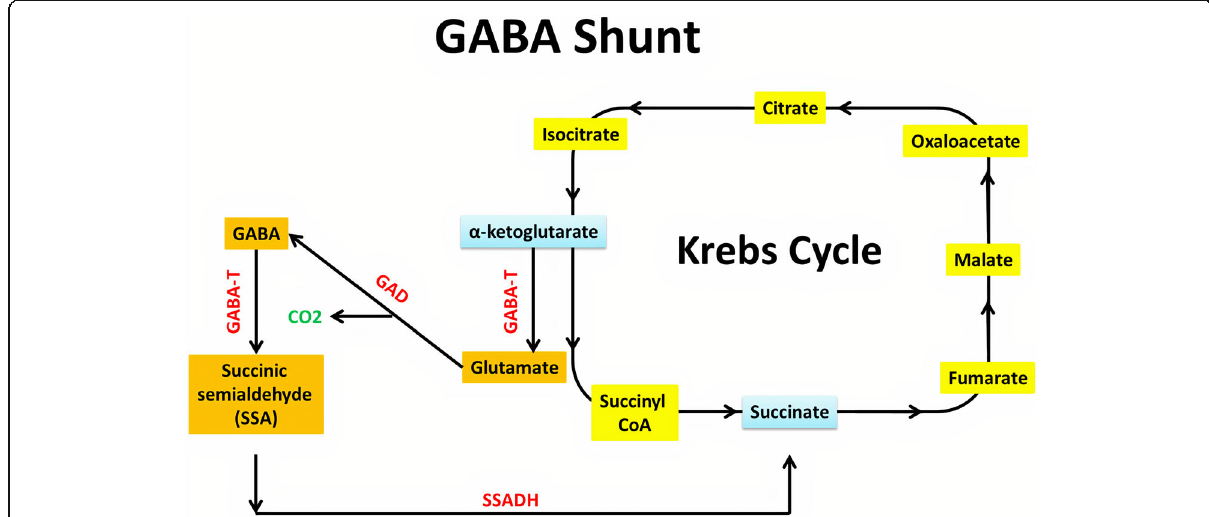
Fig. 2 Schematic illustration of GABA shunt. Transamination of α -ketoglutarate by GABA- α ketoglutarate transaminase (GABA-T) to produce glutamate which is decarboxylated to GABA by glutamic acid decarboxylase (GAD). GABA-T metabolizes GABA to succinic semialdehyde which is oxidized to succinate by succinic semialdehyde dehydrogenase (SSADH). Then, succinate can enter the Krebs cycle and complete the